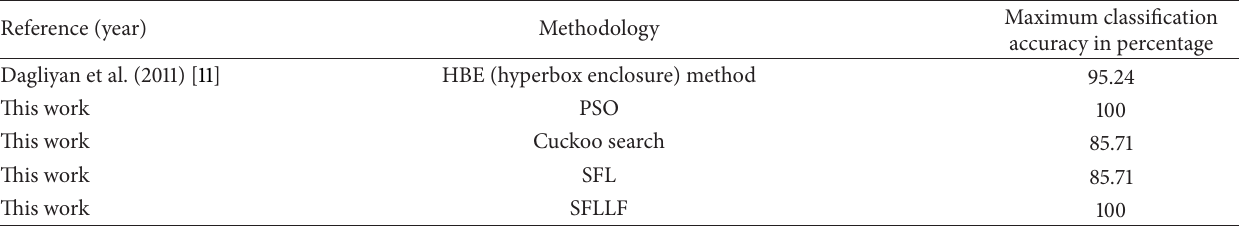
Table 9: Comparison of classification accuracy with other methods for Prostate